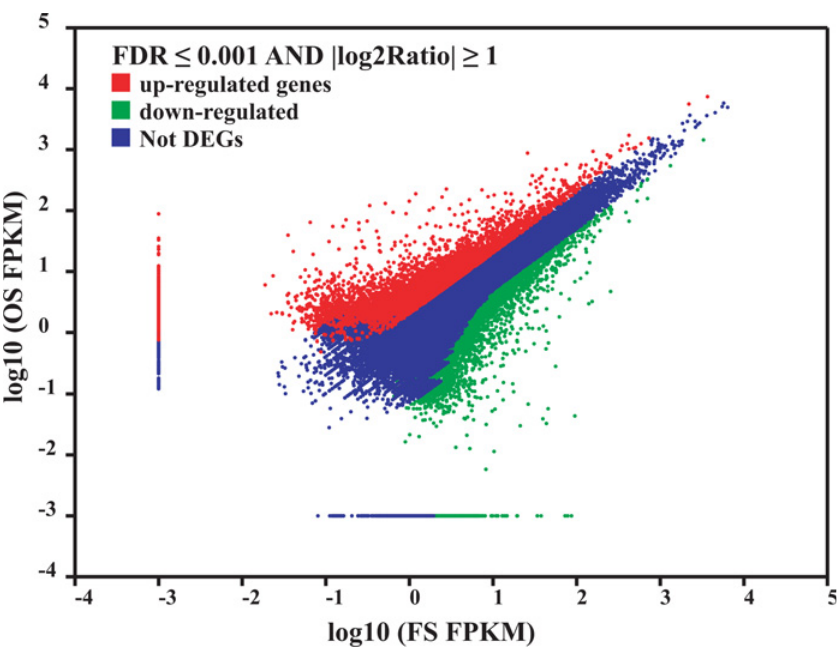
Fig 5. Identification of the DEGs (differentially expressed genes) between FS and OS. The DEGs were determined using a threshold of FDR (cid:1) 0.001 and an absolute value of log 2 Ratio (cid:3) 1. The red, green and blue spots represent the upregulated, the downregulated DEGs and the genes without obvious changes in response to grazing, respectively.